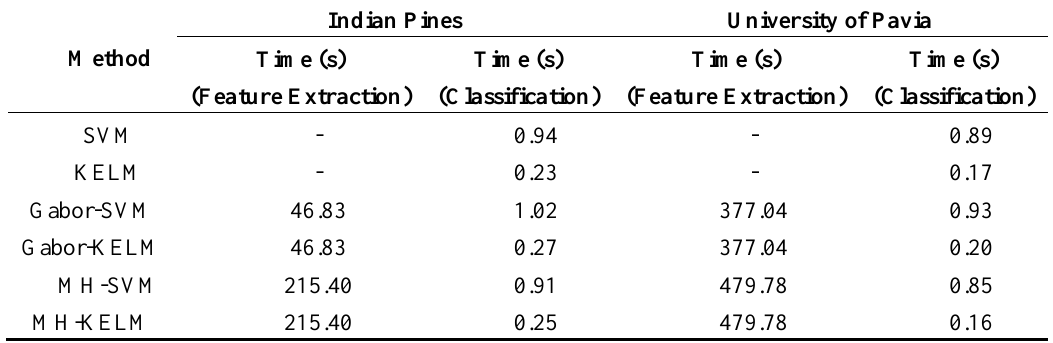
Table 10. Execution time for the Indian Pines dataset (nine classes, 180 training and 9054 testing samples) and the University of Pavia dataset (180 training and 7920 testing